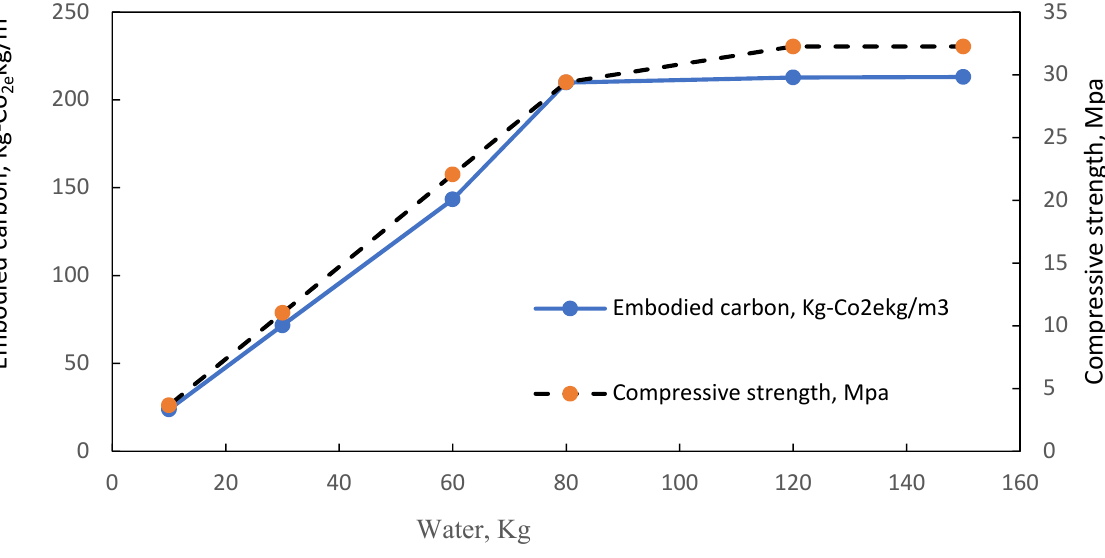
Figure 12. LCC at optimal water content of 130-150 litres per m 3 of concrete Batch A [32].